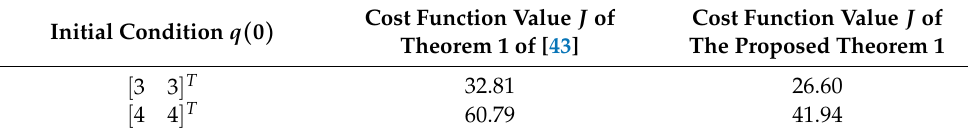
Table 1. Comparison of the cost function value J in Example 1.